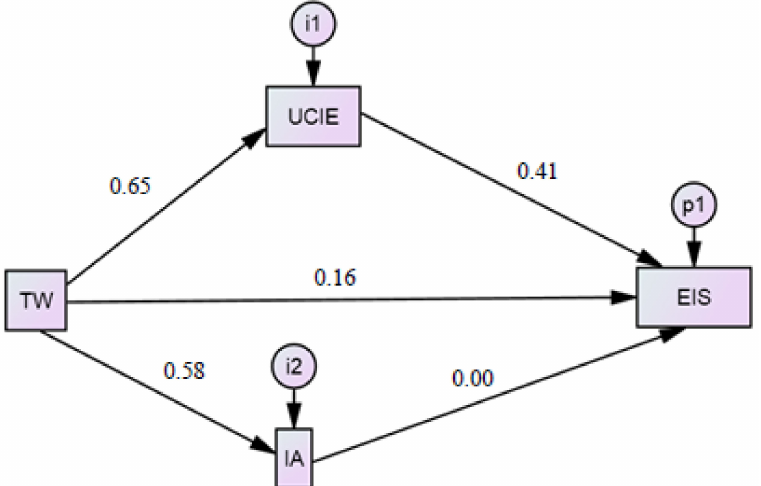
Figure 4. The diagram of the relationships in structural equation modeling. Source: Developed by the authors using AMOS for SPSS. Note: T.W.—telework; E.I.S.—employment in services; UCIE—